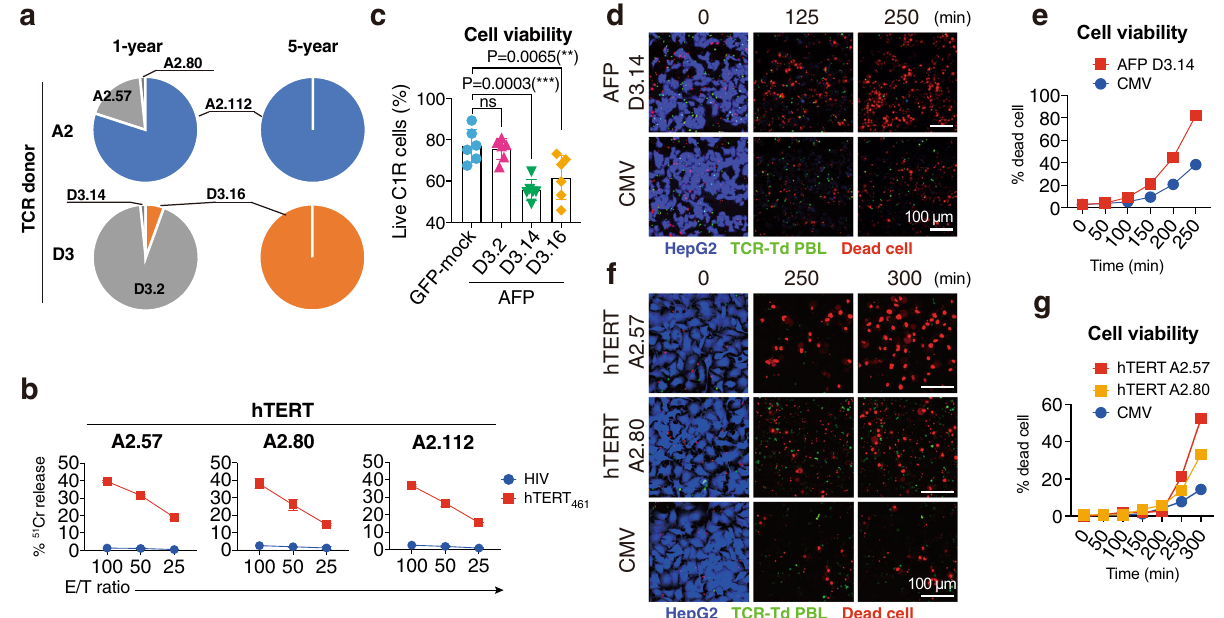
Fig. 4 Peptide-speci fi c T cell receptor repertoires over time. A2 from the hTERT trial and D3 from the AFP trial were analyzed. AFP 357 was used to analyze the TCR repertoire in D3 in this experiment. The repertoires were presented in pie charts. The size of each pie indicates the frequency of the clone in the total obtained repertoire. The same pies and the same colors represent identical TCR pairs including TRAV/TRAJ and TRBV/TRBJ/TRBD as well as CDR3 αβ sequences ( a ). Three TCR pairs obtained from A2 were tested for their function by 51 Cr release assay. The experiments were done in triplicates. % 51 Cr release were shown in the graphs. Error bar, + / − s.e.m. b . Three TCR pairs obtained from D3 were tested by the luciferase-based killing assay. Mean viabilities from two independent experiments were combined and presented in a bar graph. Each experiment was performed with triplicates. One-way ANOVA was carried out followed by Bonferroni and Sidak ’ s multiple comparison test. *** P < 0.0005; ** P < 0.005; ns, not signi fi cant; error bar,